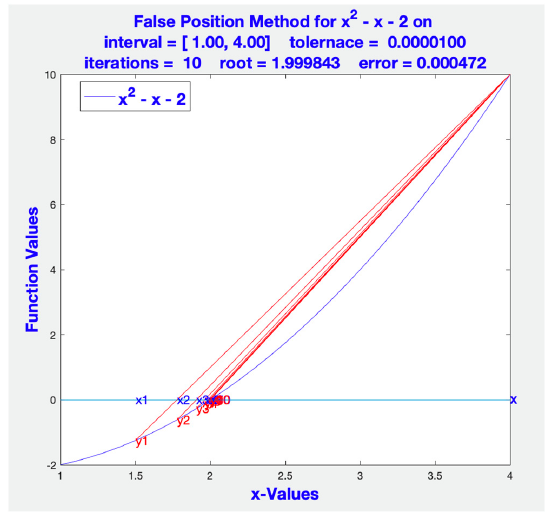
Figure 7. Plot of false position algorithm execution. Mathematics 2019 , 7 , 1118